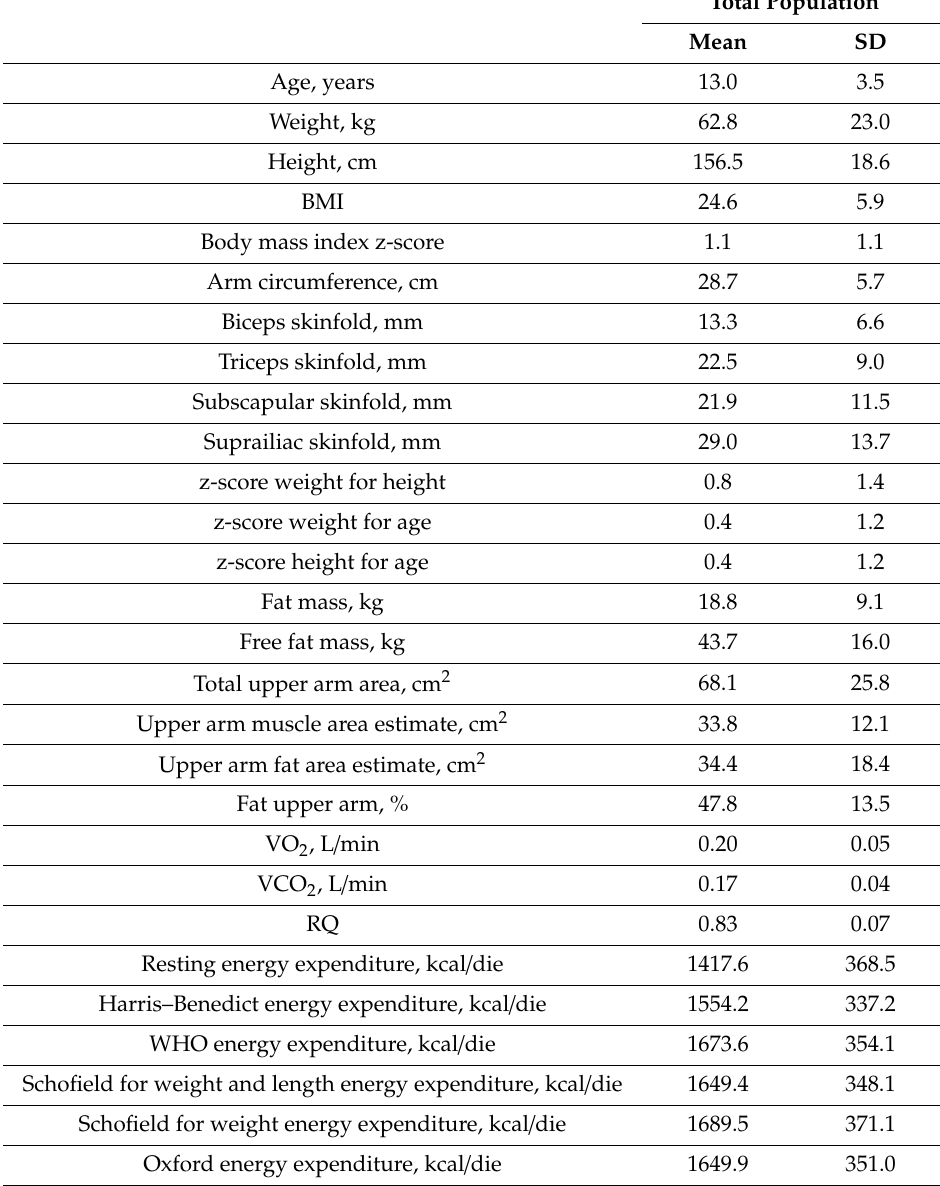
Table 1. Anthropometric and metabolic measurements of the study